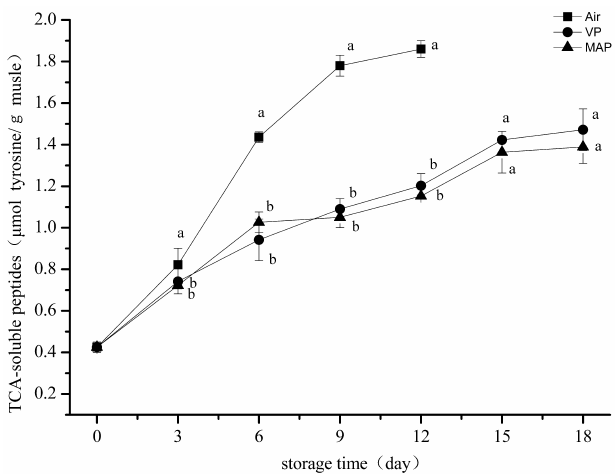
Figure 4. Changes in trichloroacetic acid (TCA)-soluble peptides of grouper myofibrillar protein (AP: